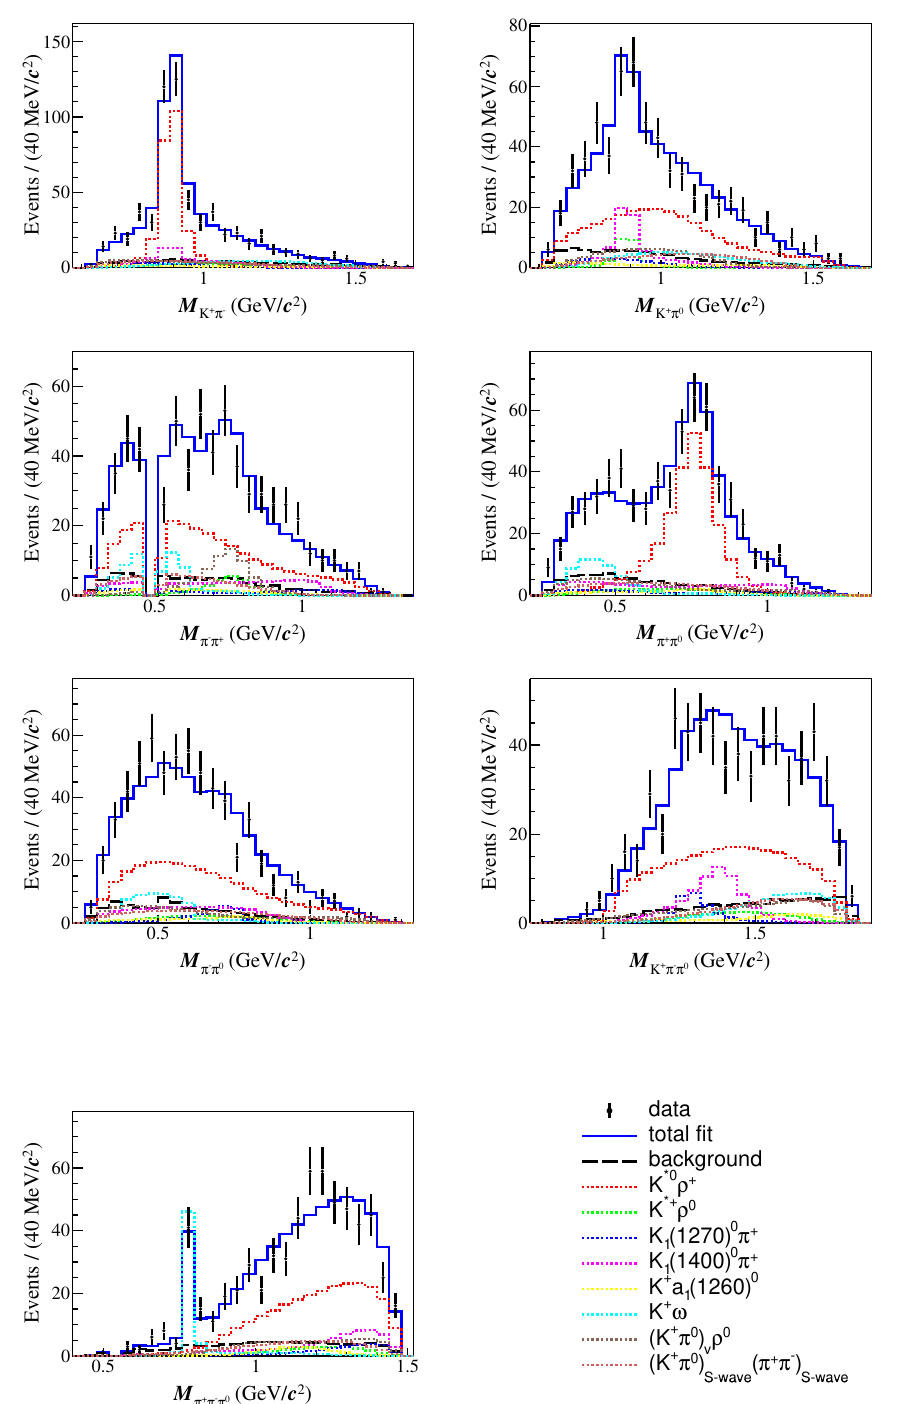
√ s = 4 . 178 – 4 . 226 GeV